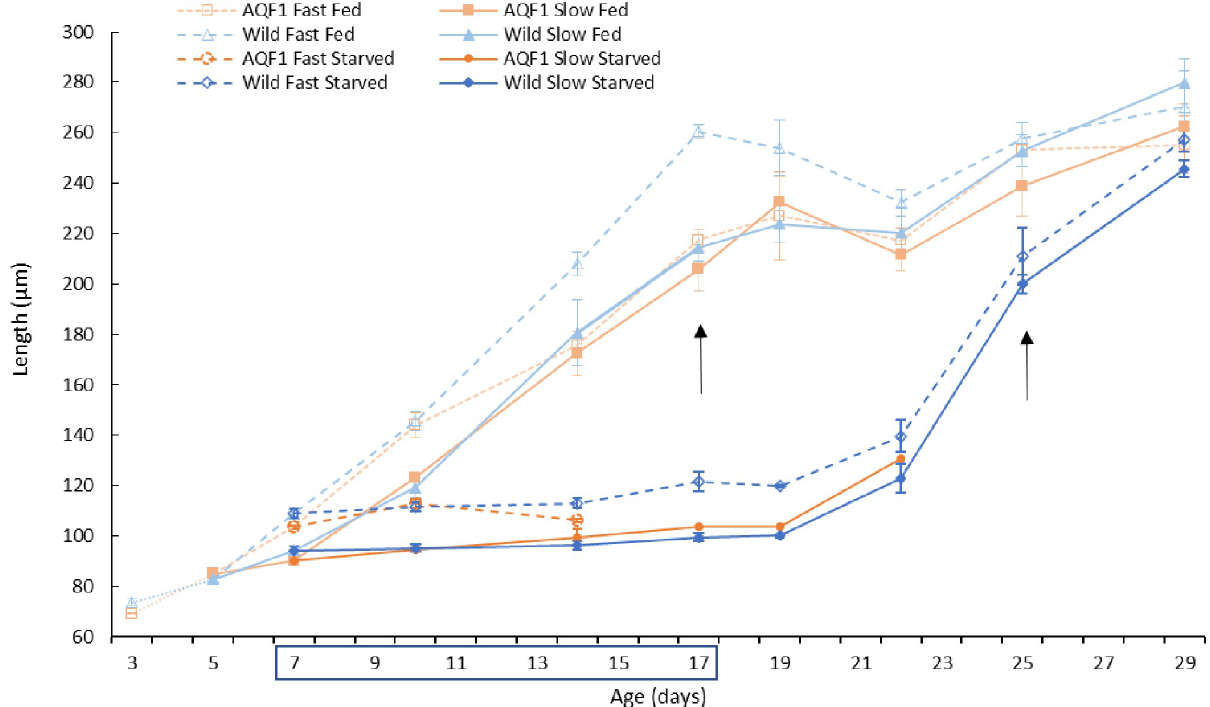
Fig 5. Mean shell length over time for each line by cohort grouping in fed controls and starved treatment. Culture from days 3–7 post fertilization occurred in 200-L larval tanks (prior to starvation) and size-based experiments in 20-L tanks. Shell lengths for fed controls after age 14 days and starved treatments after age 22 days should be interpreted with caution because settlement of large individuals out of the larval pool may have biased the size distribution. Arrows indicate days in which settlement was clearly observed in each treatment. Age 7–17 days represent the period of starvation, indicated by the blue box on the x-axis. Error bars represent standard error. Due to low survival in the AQF1 cohorts, length measurements were not possible after age 14 and 22 days for fast and slow growers, respectively. Additionally, from age 17 to 22 days in the AQF1/Slow cohort only one replicate of length measurements was possible.